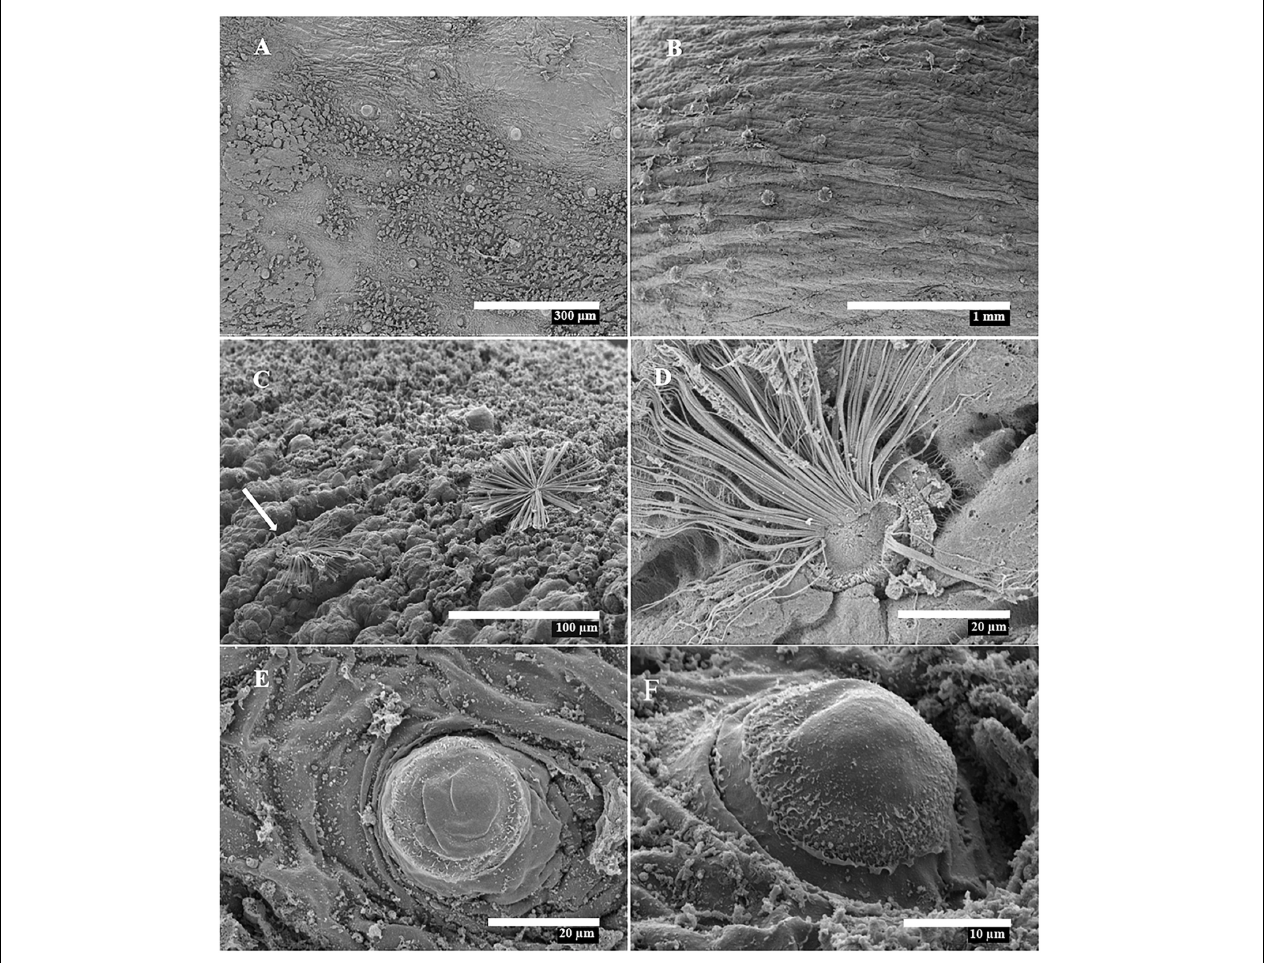
FIGURE 11 | Scanning Electron Microscopy images of wild-caught Octopus vulgaris showing Kölliker’s organ (KO) degradation. (A,B) ML 8.6 mm, dorsal mantle surface; (C–F) ML 8.1 mm, dorsal mantle and arm. (A) KO muscle stumps distributed on skin. (B) Muscle stumps together with apparently functional KO. (C) Degraded (white arrow) and functional KO on left arm I. (D) Detail of degraded KO from (C) . (E,F) Muscle stumps of degraded KO on